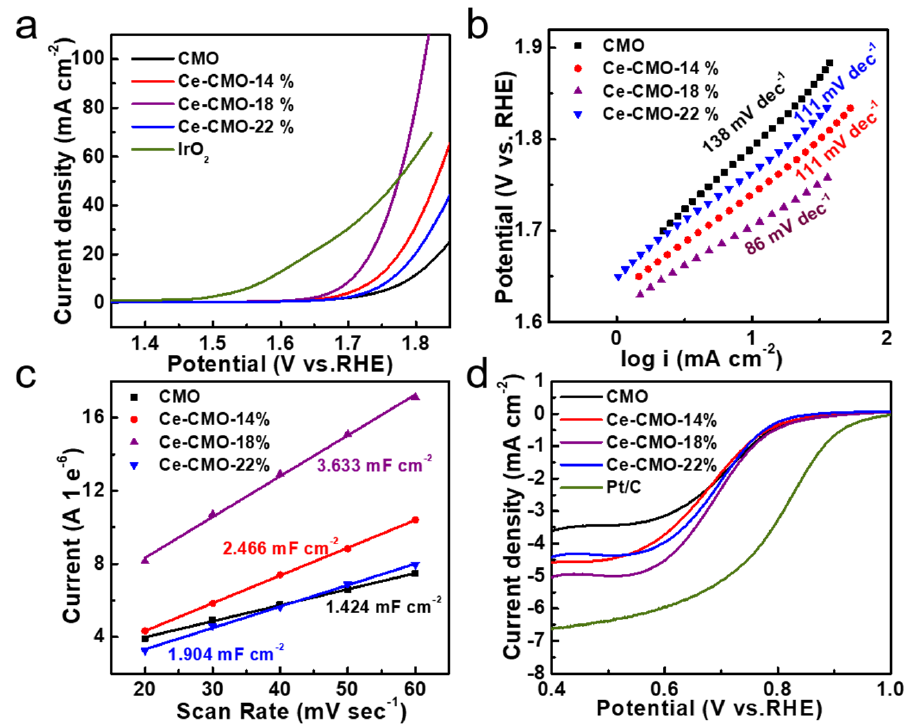
Figure 3. The OER and ORR properties of CMO and Ce-CMO-X electrocatalysts: ( a ) The undistorted iR -corrected LSV polarization curves in 1 M aqueous KOH at 10 mV s − 1 and ( b ) Tafel plots; ( c ) ECSA plots; ( d ) LSV polarization curves of the ORR in O 2 -saturated 0.1 M KOH solution at 1600 rpm. Table 2. The OER and ORR performance of CMO and Ce-CMO-X electrocatalysts.